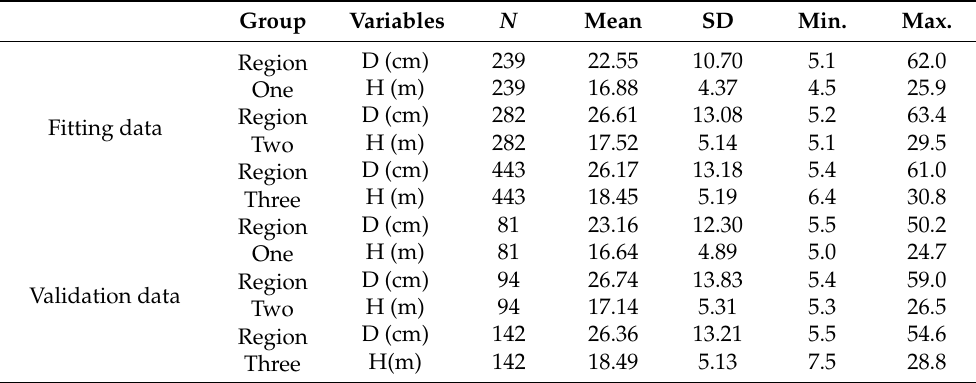
Table 1. Descriptive statistics for Dahurian larch sample trees in Daxing’anling.